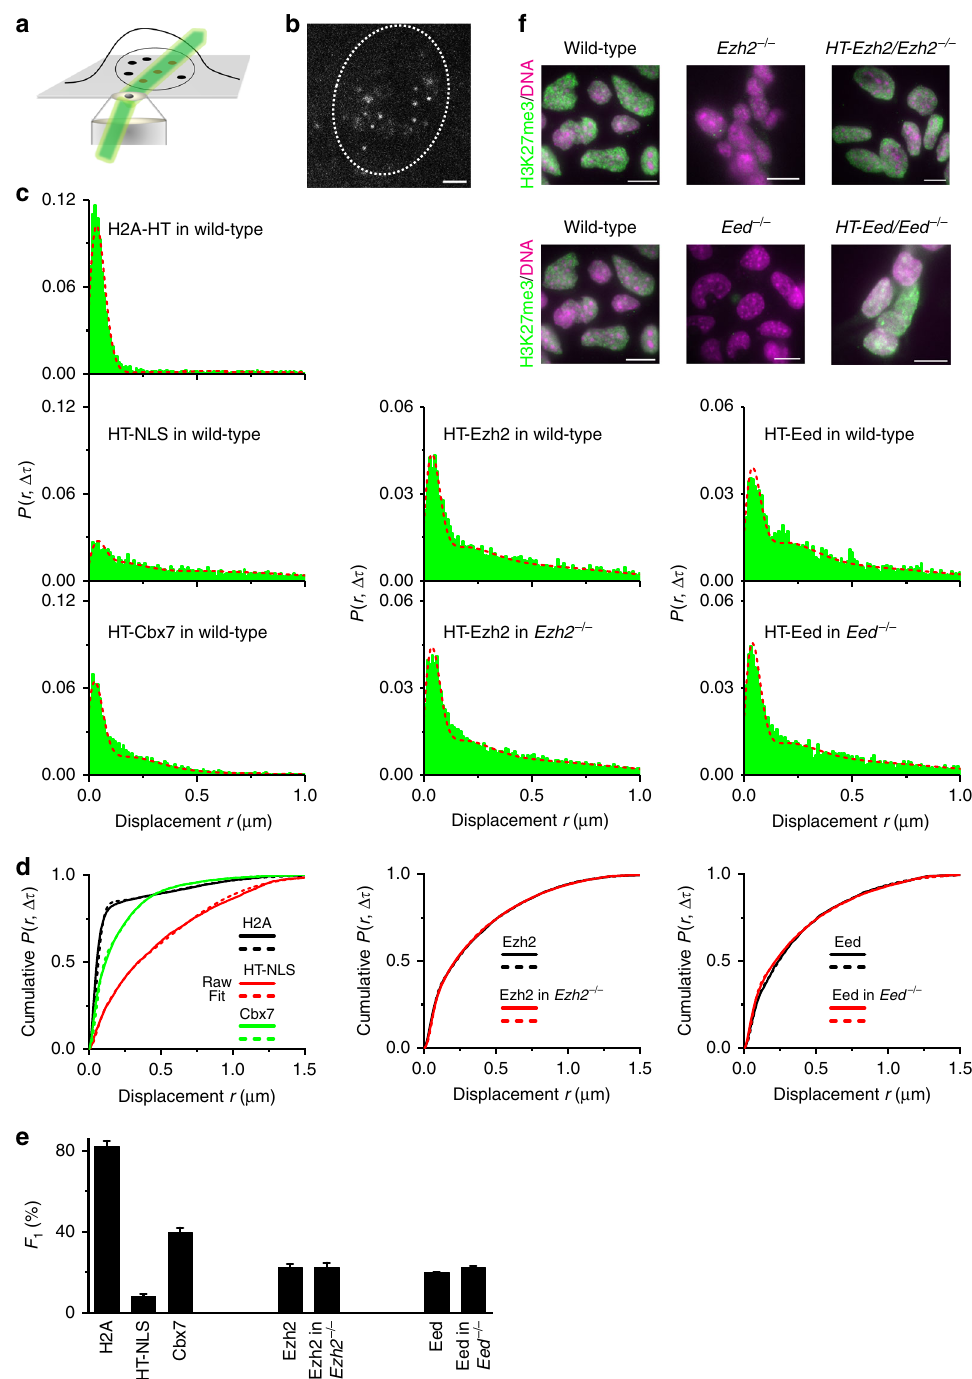
(Methods). The stability of PcG proteins on chromatin is deter- mined by their residence time. To measure the residence time of Ezh2 and Eed on chromatin, we performed live-cell SMT at an integration time, τ int , of 30 ms interspersed with a dark time, τ d , of 170 ms as described previously (Fig. 2a) 28 . We considered molecules whose diffusion constant is less than 0.032 (µm 2 per s) as the chromatin-bound ones. This is a conservative considera- tion since we intend to avoid counting molecules of con fi ned motion whose diffusion constant is at a range of 0.32 – 0.77 (µm 2 per s) (Supplementary Table 1). We counted the lifetime of the fl uorescence spots as the dwell time of individual